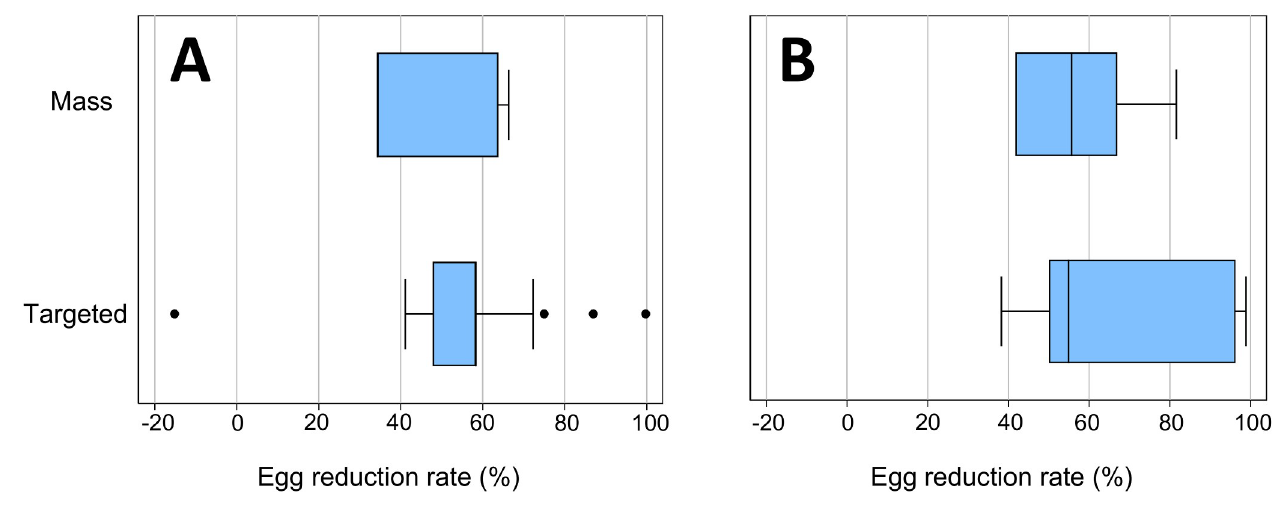
Fig 2. Boxplots of infection intensity reduction for S . mansoni (A) and S . haematobium (B) for studies using mass and targeted strategies. Studies were weighted according to their sample